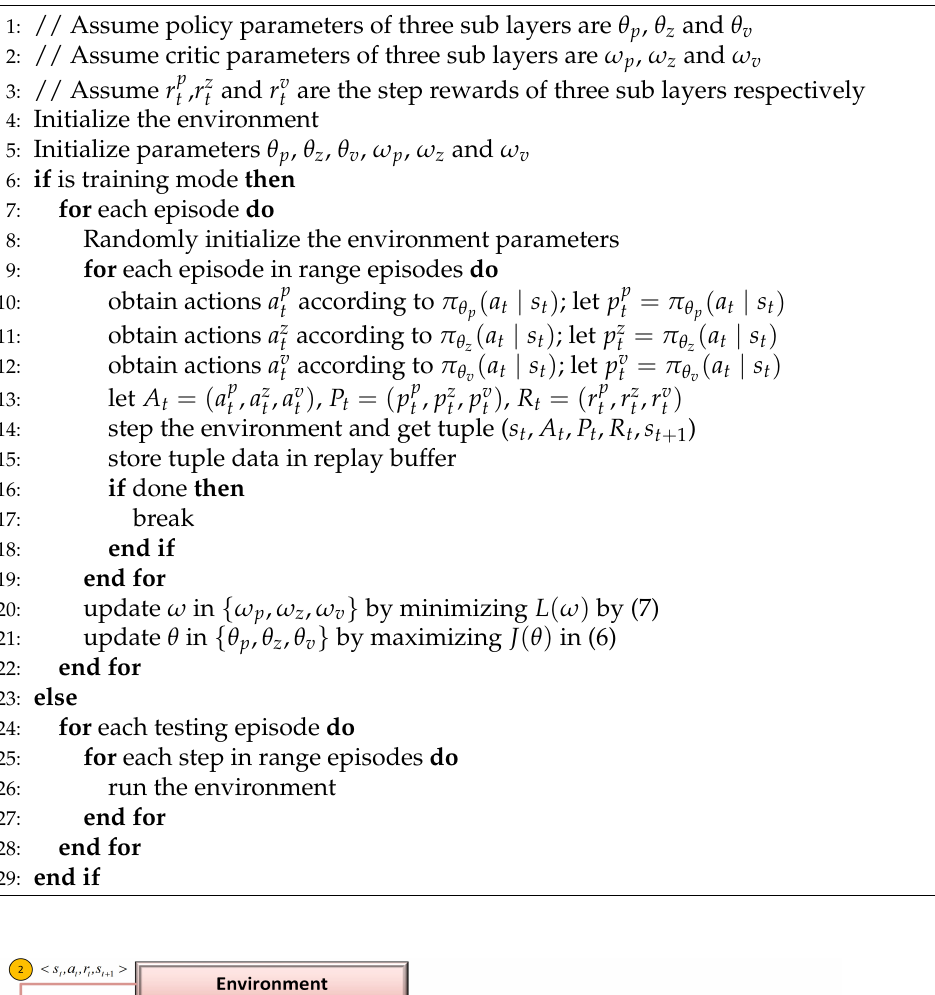
Algorithm 1 Multi-layer RL algorithm.